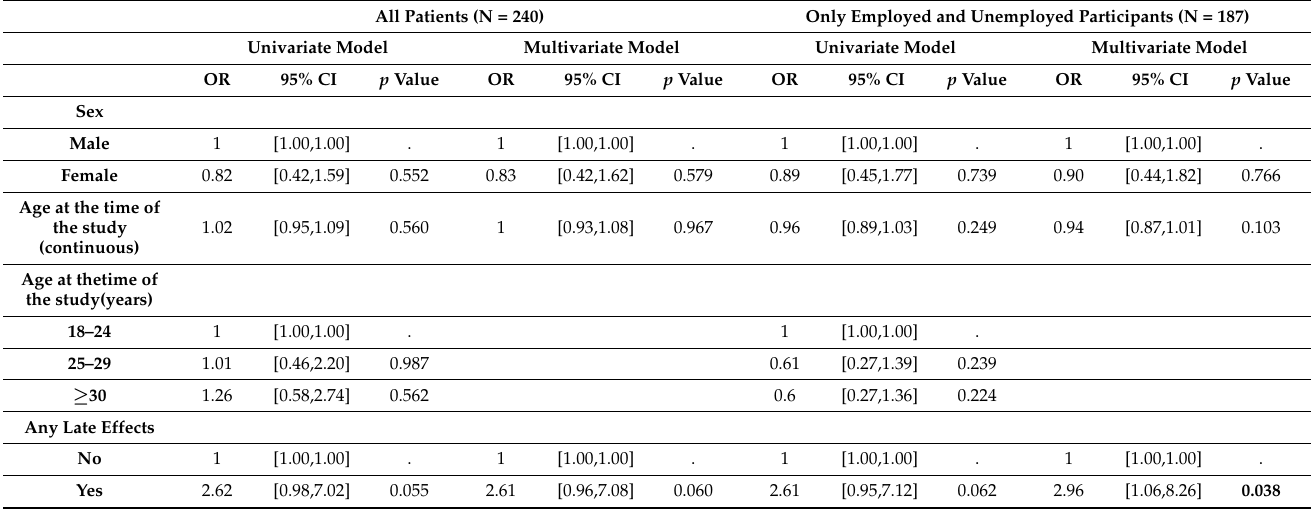
Table 3. Crude and adjusted effects on unemployment.